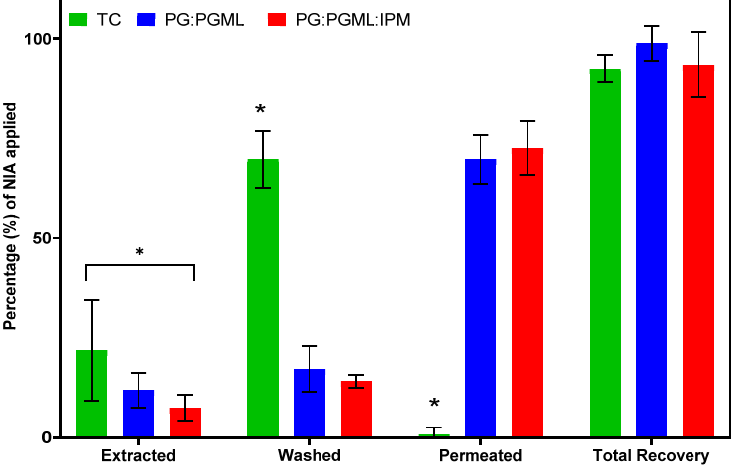
Figure 2. Percentage (%) recovery values of NIA for various solvent systems following mass balance studies in human epidermis (4 ≥ n ≥ 3; mean ± SD, one-way ANOVA, * p < 0.05).